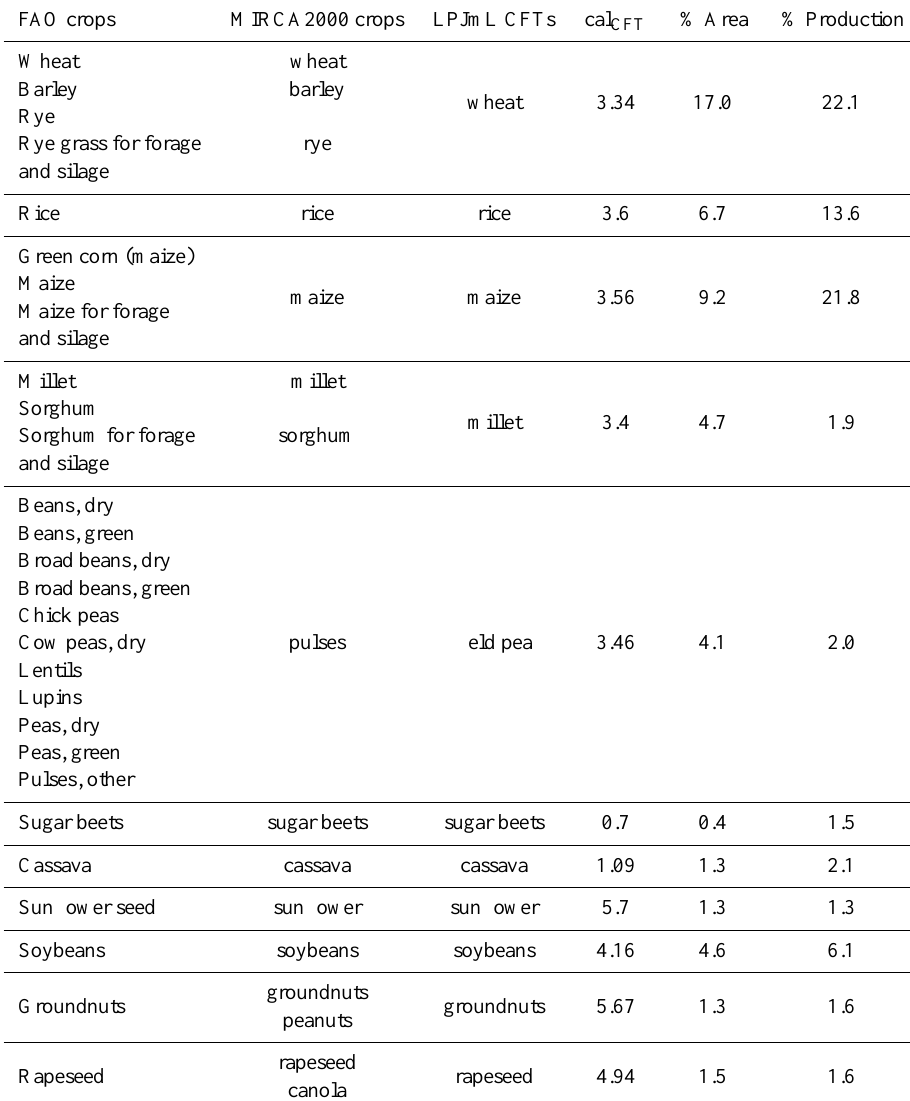
Table 3. FAO and MIRCA2000 (Portmann et al., 2010) aggregates corresponding to LPJmL CFTs. Calorie content cal CFT in Mkcaltons − 1 of fresh matter from Agribiom, followed by the share of each CFT in global cropland area in percent (1493 Mha in 2000, Ramankutty et al., 2008) and in global food crops production (mean over the 1999–2003 period: 10.5Pkcal,